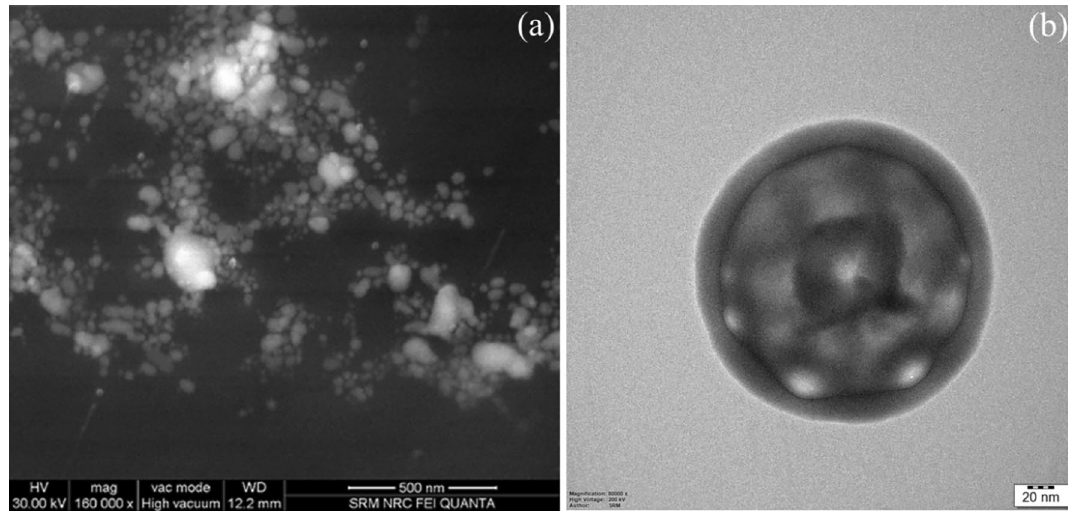
Figure 9. Vesicle morphology, ( a ) FESEM image and ( b ) TEM image of DIP.